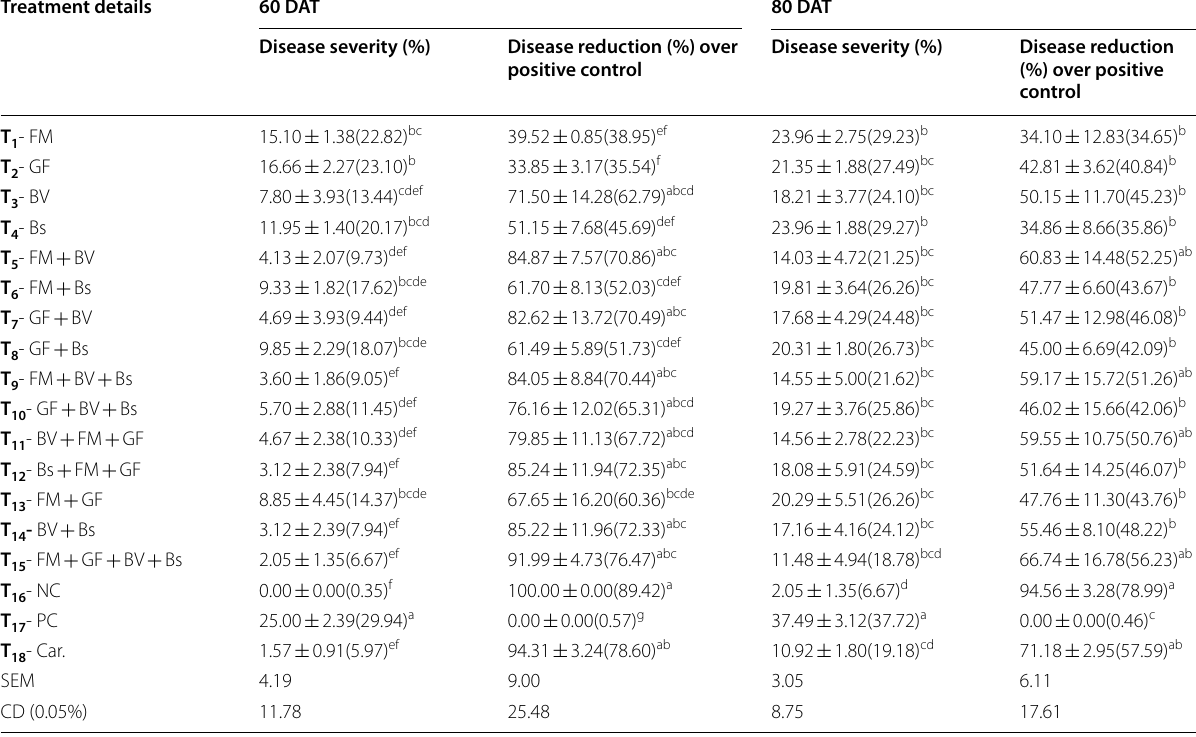
Data in parentheses are arc sine transformed values Values with different letter(s) within a column are significant at p< 0.05 by Duncan’s multiple range test (DMRT), Values are the means (